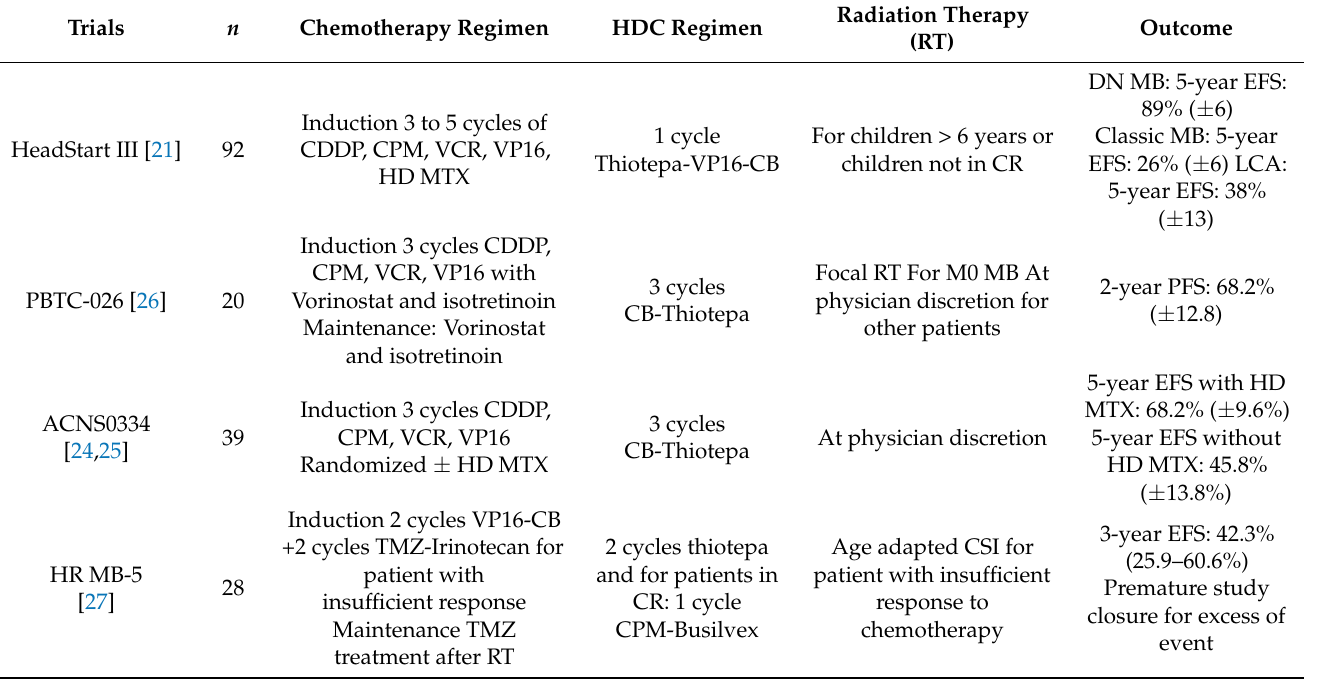
Table 2. Recent high-dose chemotherapy clinical trials for young children with newly diagnosed